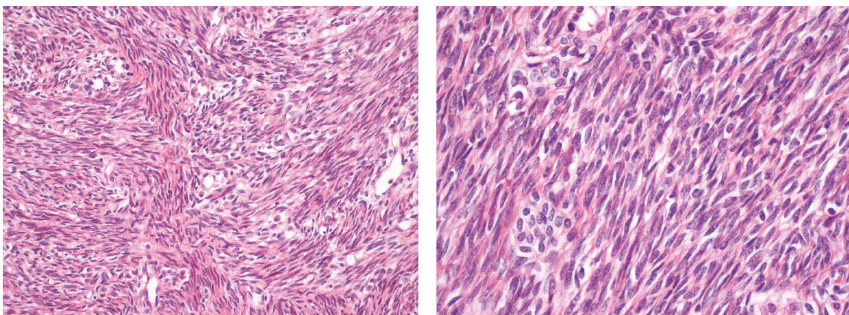
Figure 3: Histopathologic examination of BML and uterine leiomyoma of patient 2.